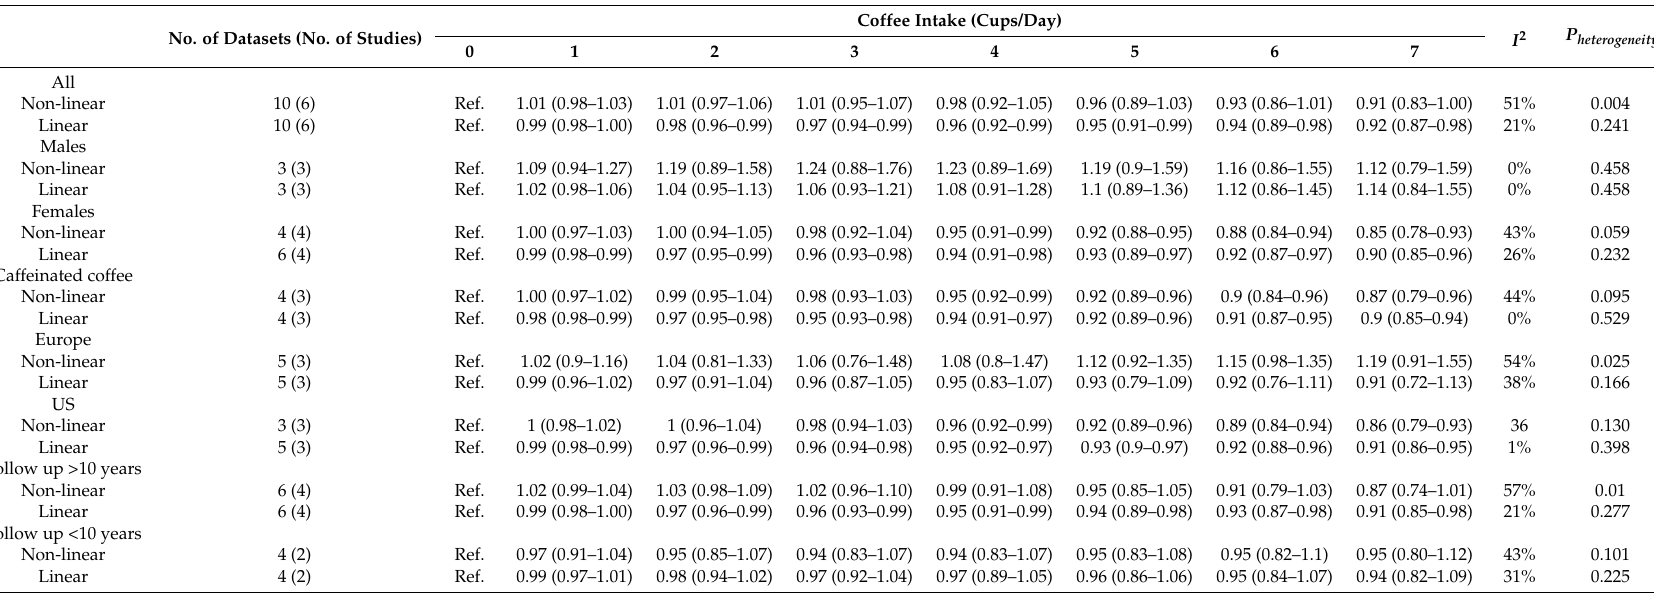
Table 2. Dose–response meta-analysis of coffee consumption and risk of hypertension, stratified by selected variables. No. of Datasets (No. of